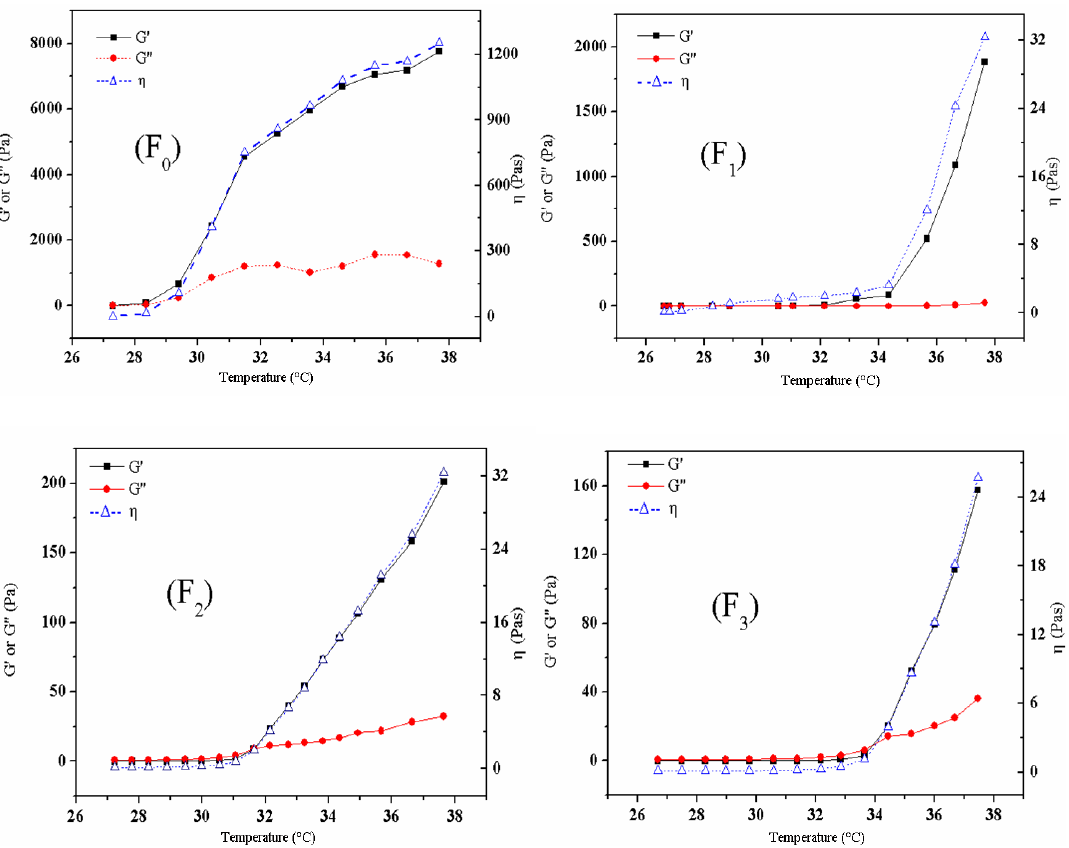
Figure 2. The effect of NB/HP- β -CD concentration on rheological properties of thermosensitive composite hydrogel (F Thermosensitive composite hydrogel adding 1% NB/HP- β -CD; F composite hydrogel adding 2% NB/HP- β -CD; F adding 3% NB/HP- β